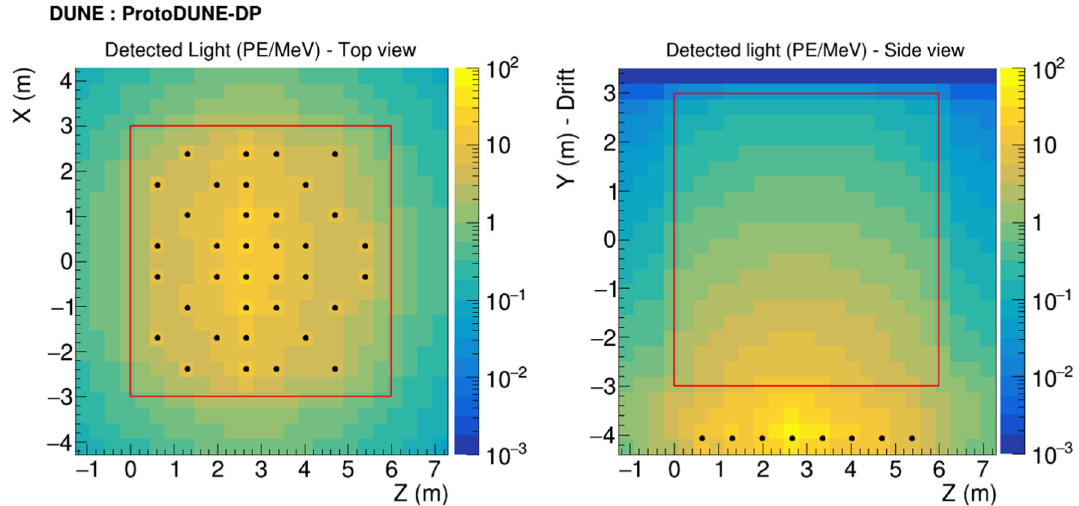
Fig. 13 Maps of the detected light (sum of PMT visibilities multiplied by efficiency, E TPB = 0 . 09 and E PEN = 0 . 016) per voxel for the base- line photon library in ProtoDUNE-DP: 4 · 10 4 photons per MeV, 99.9cm